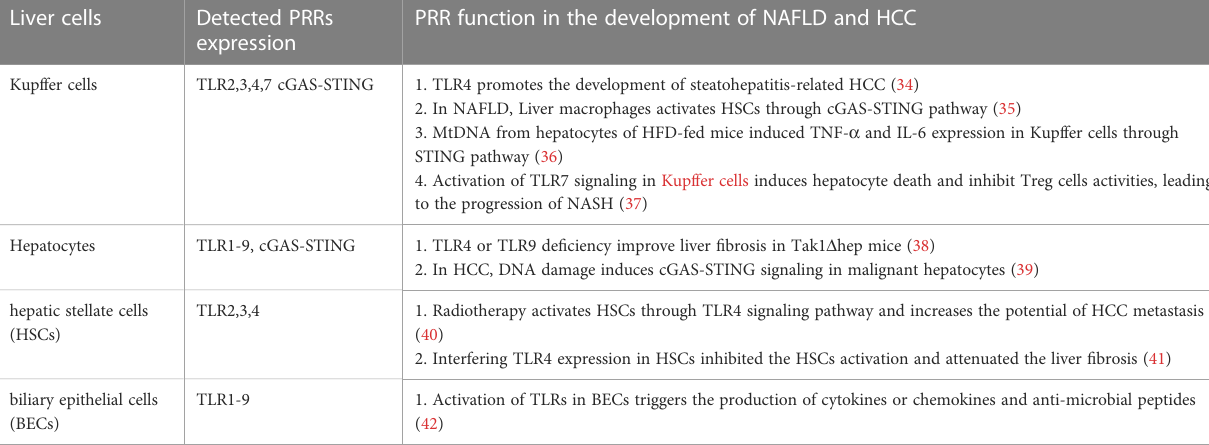
TABLE 1 The expression and action of TLRs and cGAS-STING in a variety of liver